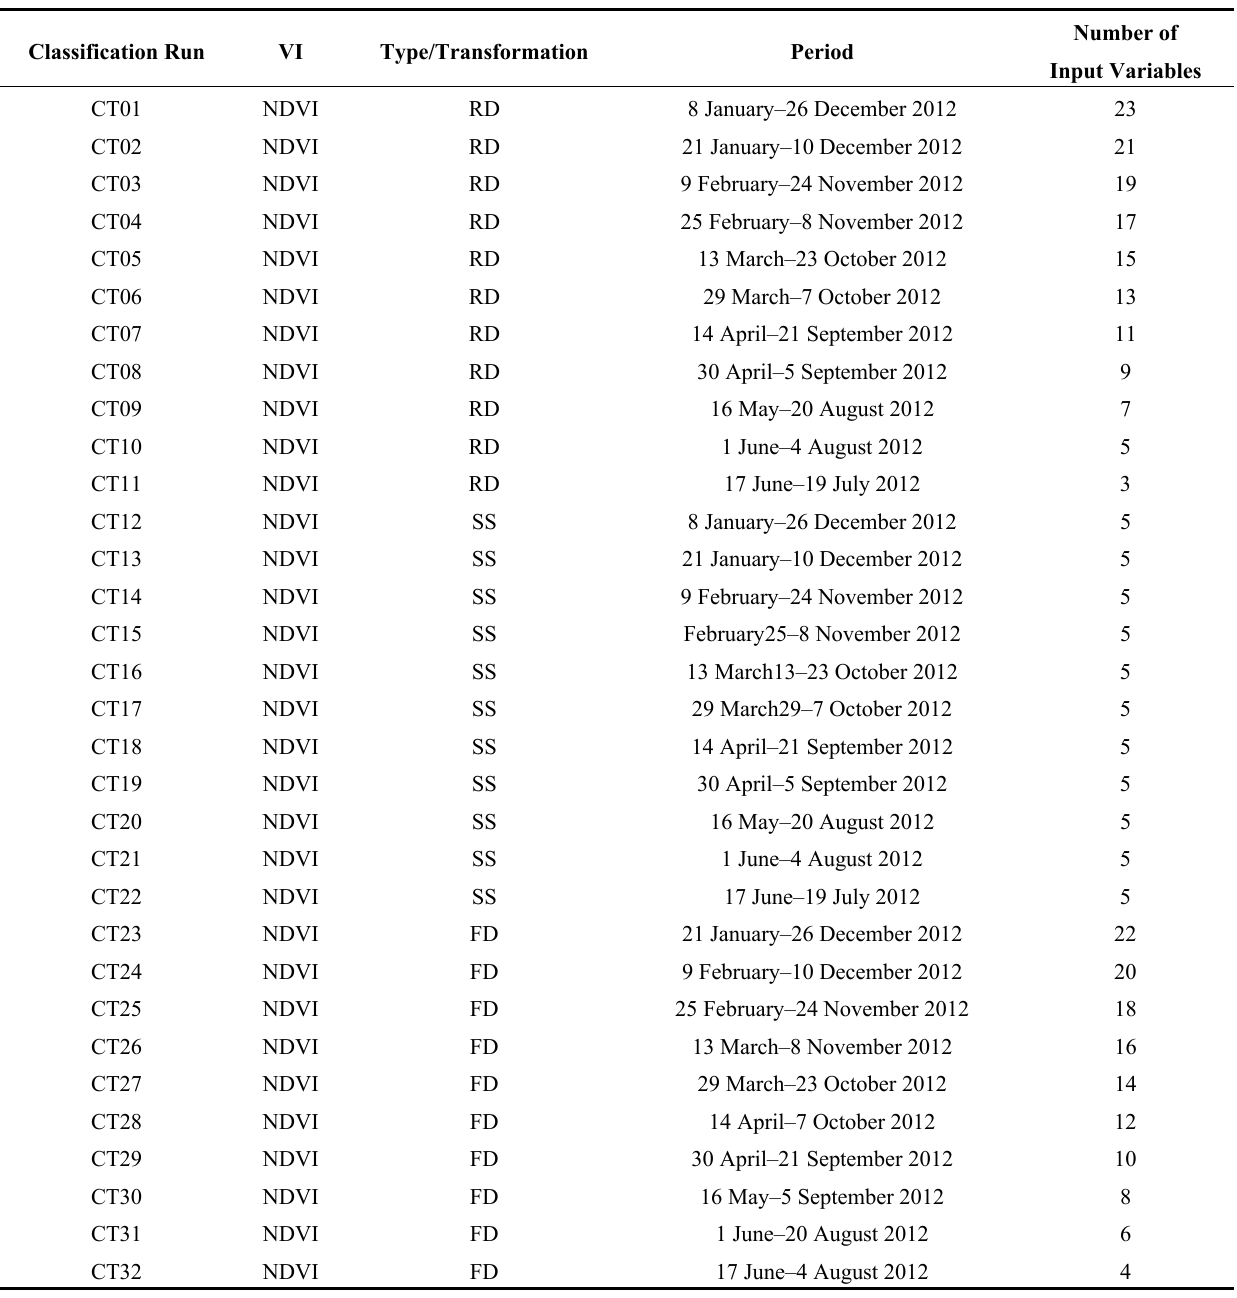
Table 2. List of all classification runs with different data series. The best case series for different types of the data sets are marked in bold. RD—raw data, SS—seasonal statistics, FD—first difference, FA—Fourier